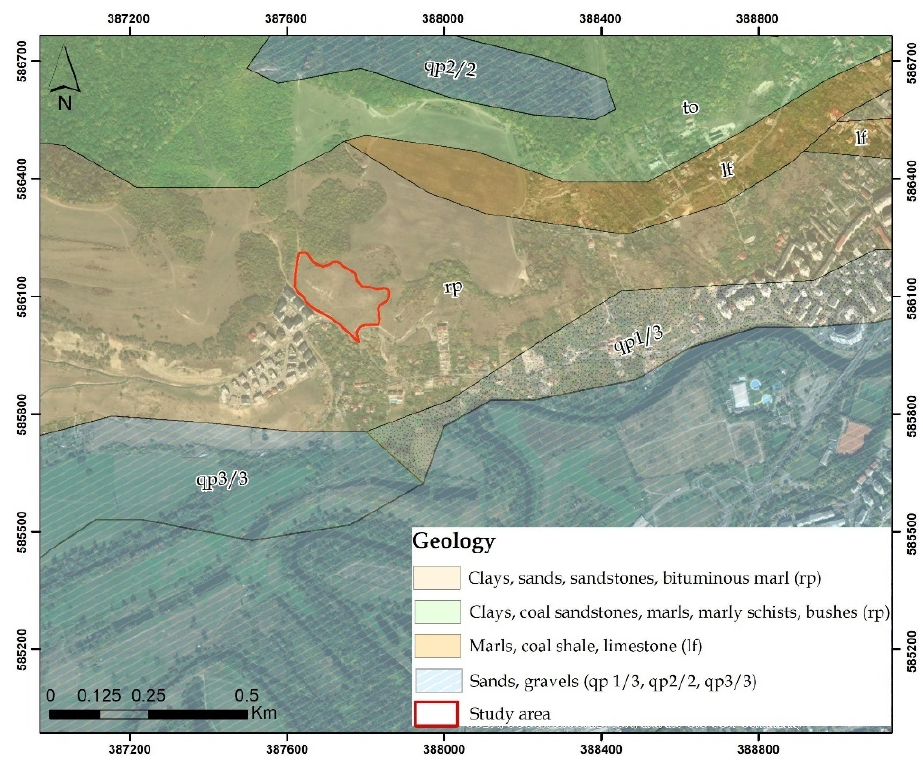
Figure 4. Study area geology based on the Geological Map of Romania, 1:200,000.